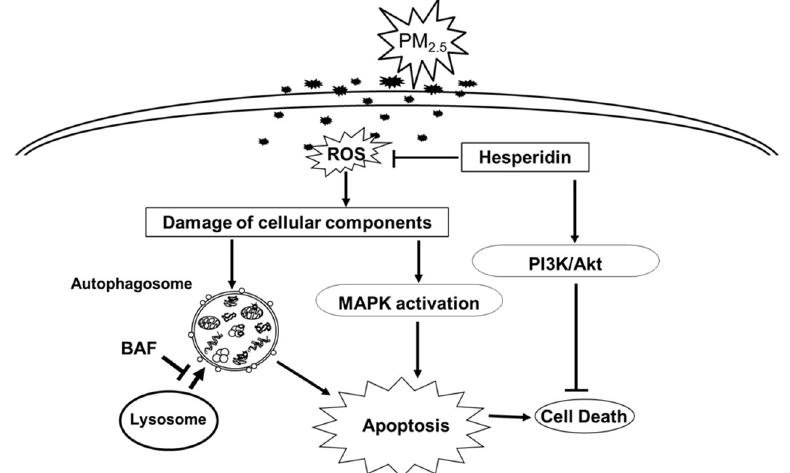
Figure 6. Schematic diagram summarizing the protective mechanism of hesperidin against PM 2.5 - induced cell damage. Hesperidin protects keratinocytes by suppressing PM 2.5 -induced intracellular ROS generation, intracellular macromolecules damage, autophagy activation, and cell apoptosis. Hesperidin alleviates cell apoptosis via the inhibition of PM 2.5 -induced MAPK activation as well as excessive autophagy activation, which may cause the uncontrolled degradation of intracellular components that eventually results in apoptosis and cell death. Furthermore, hesperidin restored the PM 2.5 -mediated decrease in cell viability via the activation of the PI3K/Akt pathway.